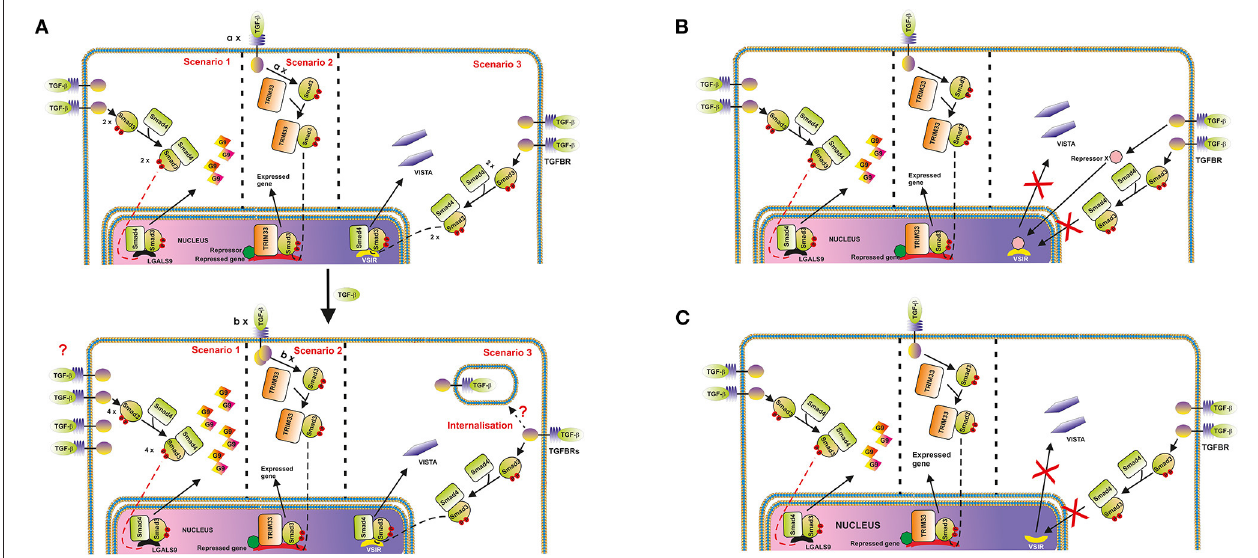
FIGURE 4 | Possible mechanisms underlying the differential regulation of protein (and in particular, VISTA) expression by the TGF- β -Smad3 pathway. (A) Changes in cell surface-based TGFBR levels. An example where galectin-9 expression is upregulated, and VISTA is downregulated is shown. The key message of this scheme is that the expression of target proteins could be differentially regulated by the TGF- β -Smad3 pathway, recruiting Smad4/TRIM33 co-activators. Differential responses are possibly determined by alterations of TGFBR levels on the surface of target cells. In the second scenario, “a” and “b” represent numbers of respective protein molecules. (B) Possibility of activation of a hypothetical protein-repressor of VSIG is depicted; (C) TGF- β -triggered changes in the localization of VSIG-containing locus during nuclear compartmentalisation in cell types where VISTA is downregulated by TGF- β (most likely